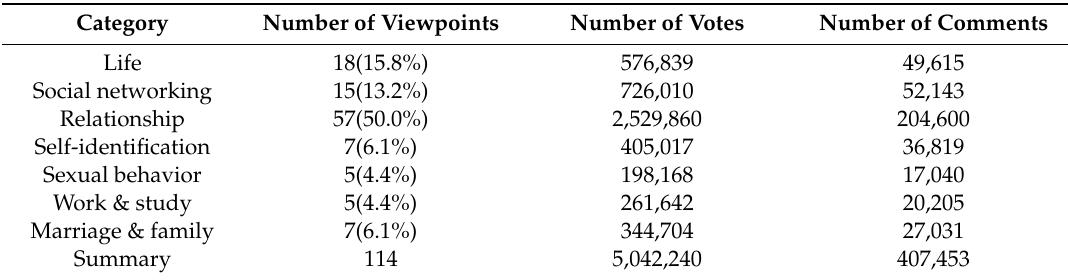
Table 6. The statistical results of the voting